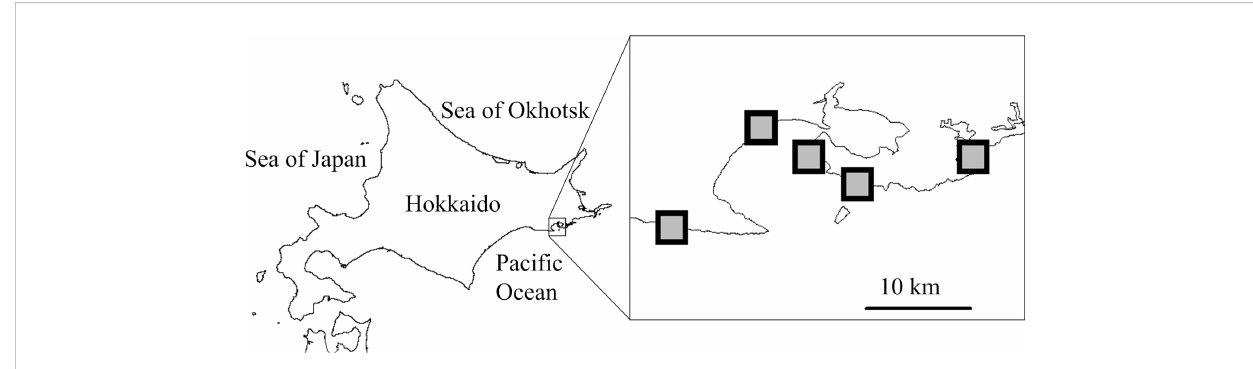
FIGURE 2 Location of fi ve rocky shores chosen for a census of intertidal organisms along the coast in southeast Hokkaido, Japan, along the Northwest Paci fi c